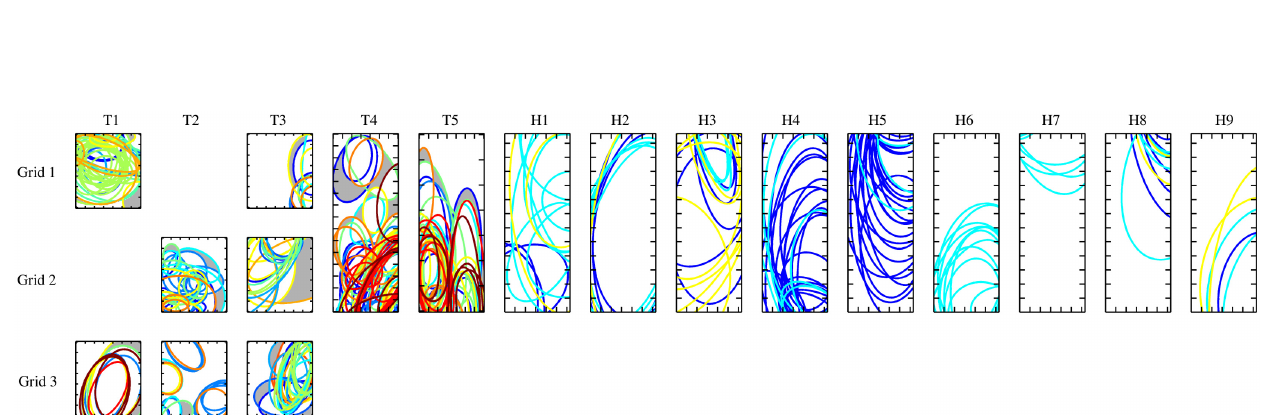
Fig 5. Mean and standard deviation of the investigated motor unit properties of the two groups. TMR patients are shown in black, able-bodied subjects in gray. The group means are depicted on the right side.